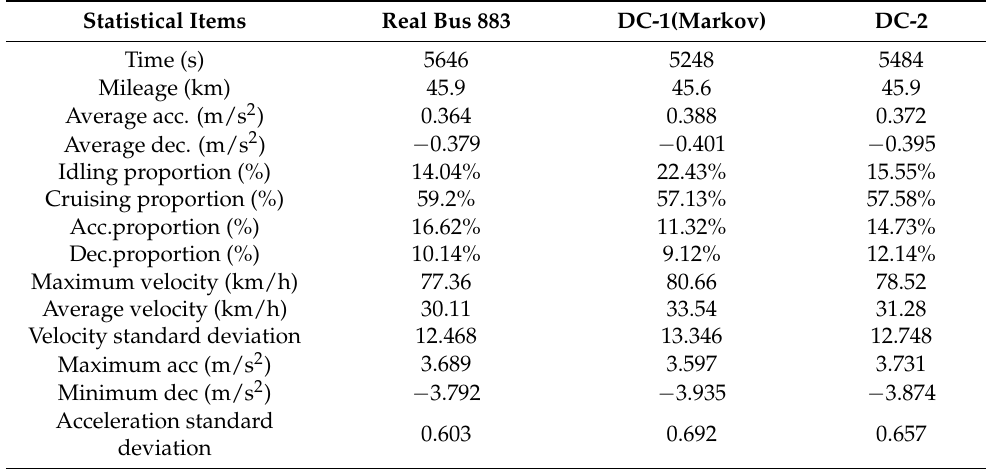
Table 2. Characteristic parameters in real DC, DC-1, and